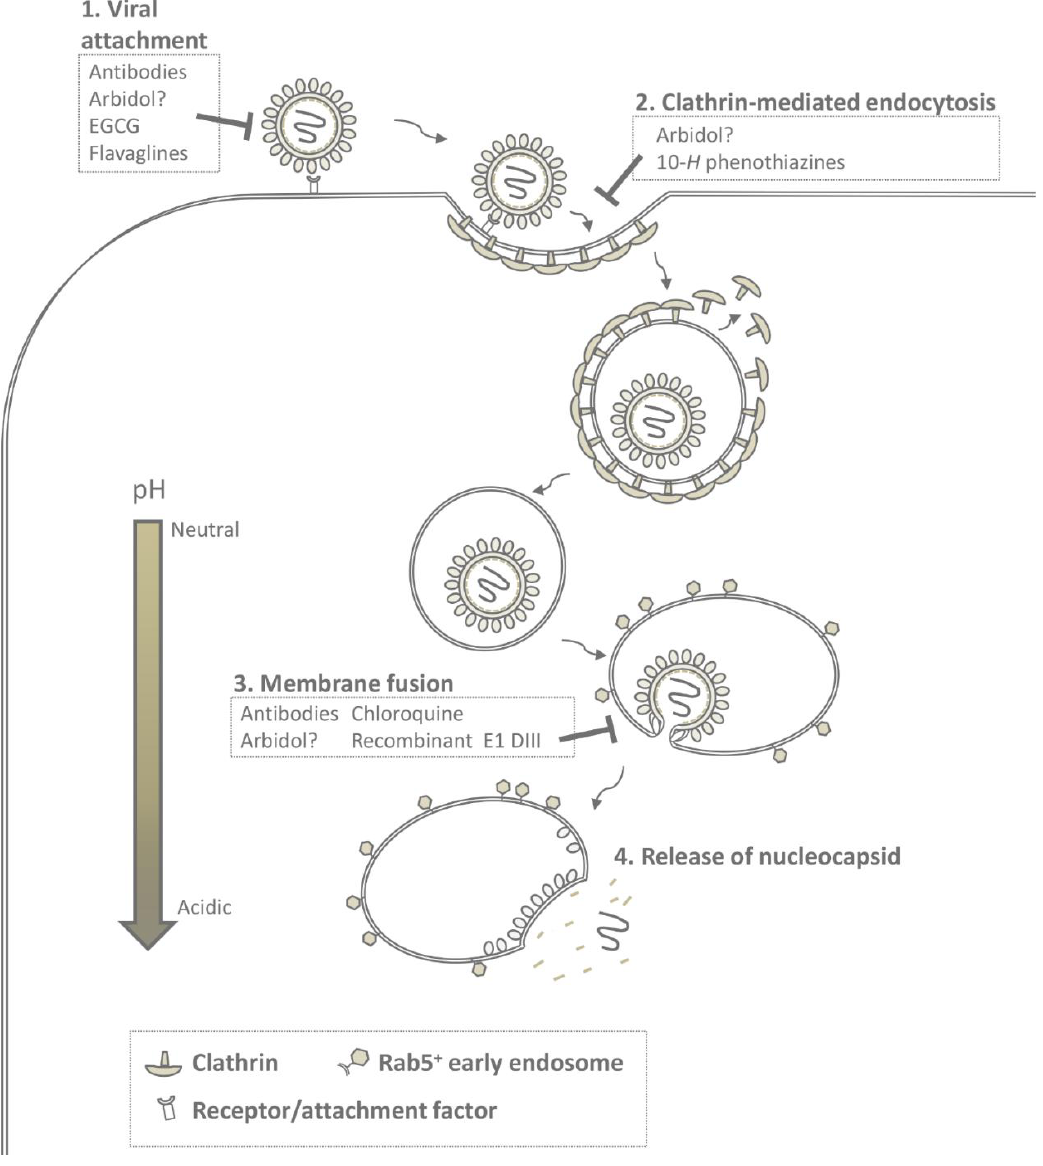
Figure 2. Chikungunya virus cell entry and potential antiviral strategies. The viral life cycle starts with attachment of the virus particle to one of the ubiquitously expressed attachment factors or receptors at the cell surface ( 1 ); Subsequently, the virus is internalized into the cell via clathrin-mediated endocytosis ( 2 ); Then, clathrin-molecules dissociate from the vesicle and the virus is delivered to Rab5 + endosomes. Within the mildly acidic lumen of the endosome, the viral glycoproteins E2 and E1 undergo major conformational changes that lead to membrane fusion ( 3 ); Thereafter, the nucleocapsid core is released into the cytosol ( 4 ). The molecules and compounds that are known to interfere with entry are stated in the boxes.